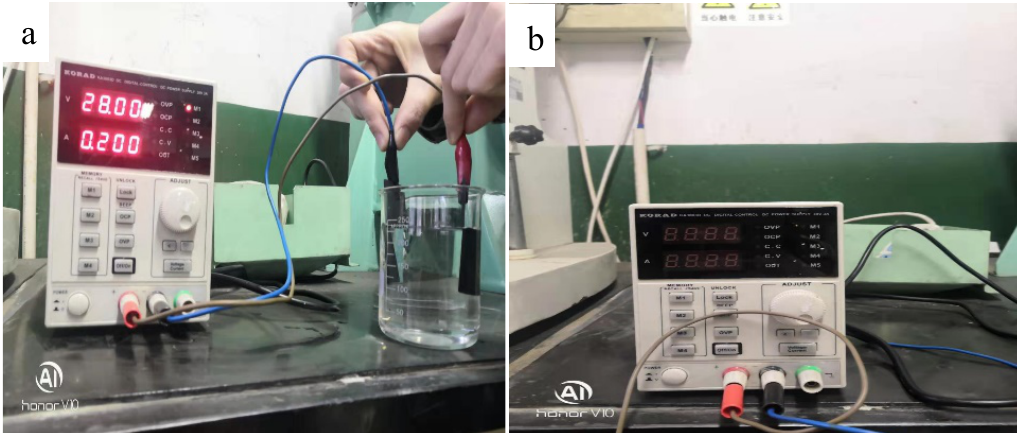
Figure 2. The electrolysis equipment and experimental process. ( a ), Electrochemical pretreatment of reagents; ( b ), DC regulated power supply.